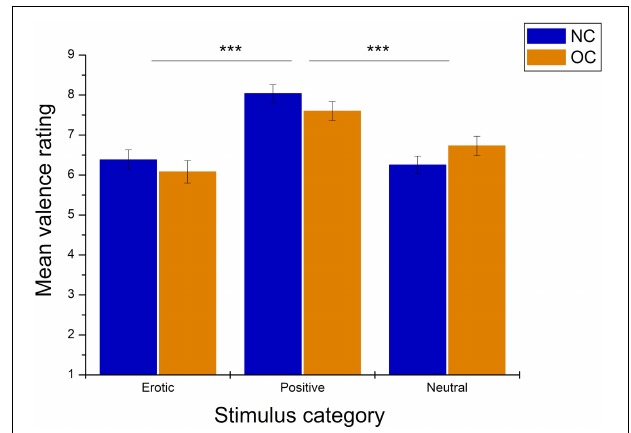
FIGURE 3 | Mean arousal ratings in reaction to erotic, positive and neutral stimuli in naturally cycling (NC) women and oral contraceptive (OC) users. Error bars reflect standard error of the mean (SEM). *** p < 0.001, ** p < 0.01.